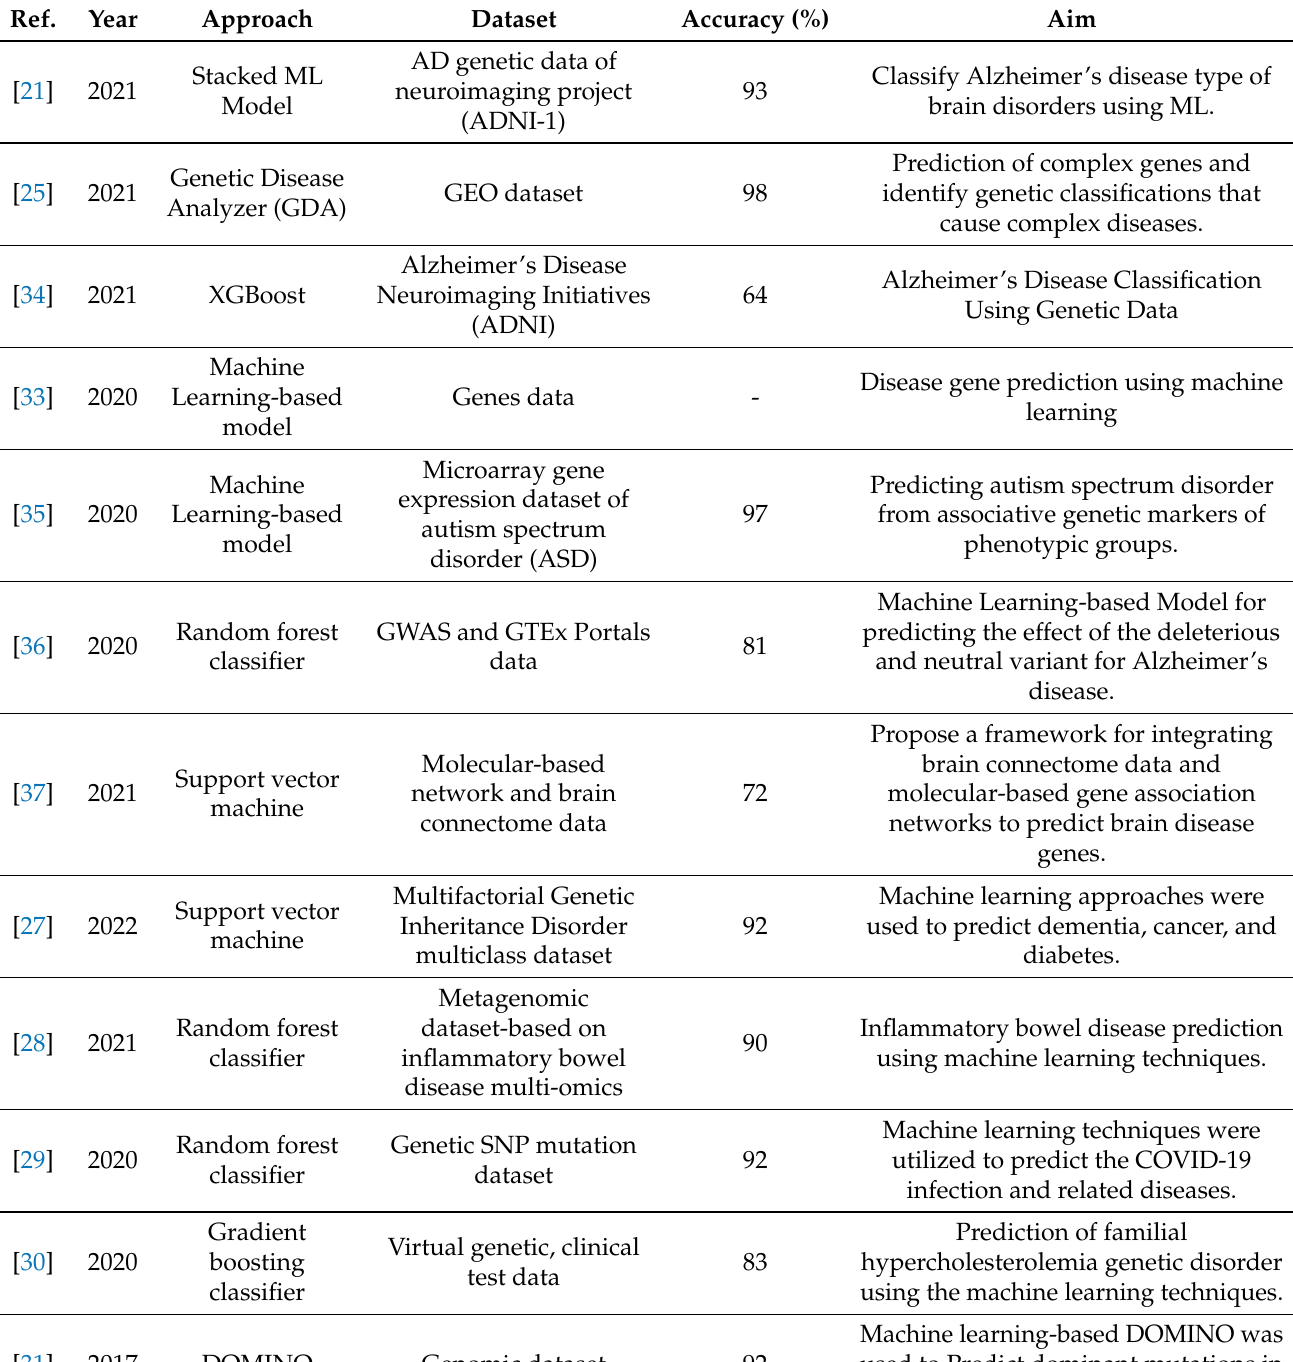
Table 1. Summary of genetic disorder-related